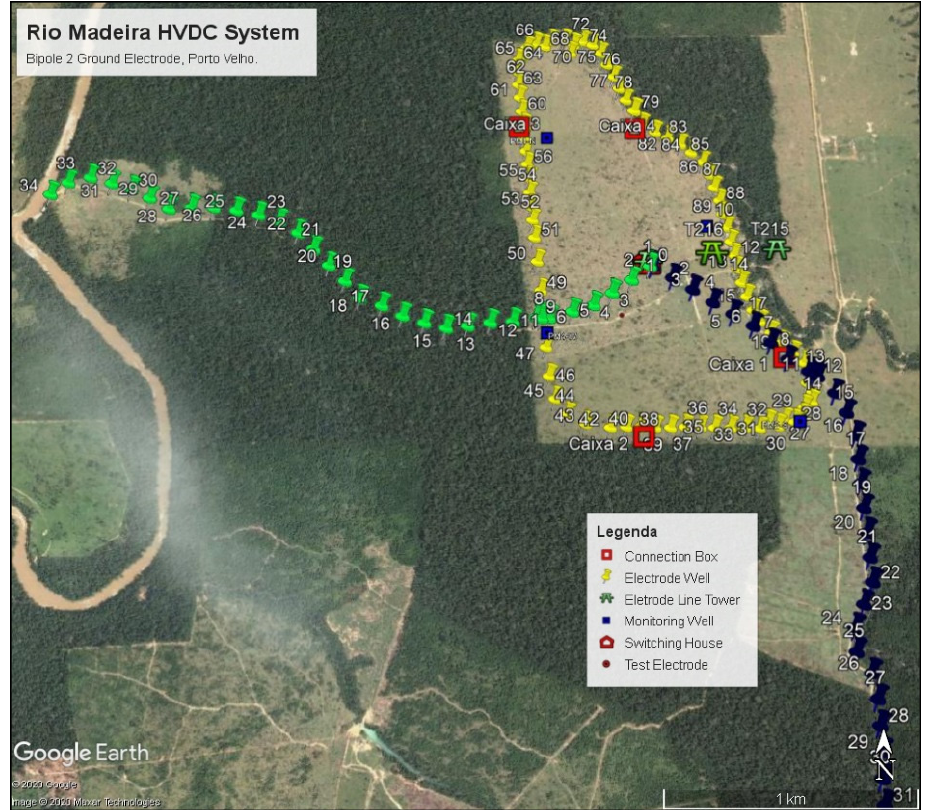
Figure 6. The two soil-surface potential survey directions–West and South (the West line was limited by a river).